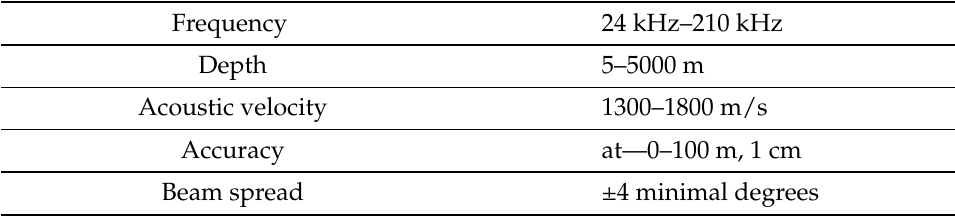
Table 1. Properties of the single-beam echosounder used in this study.